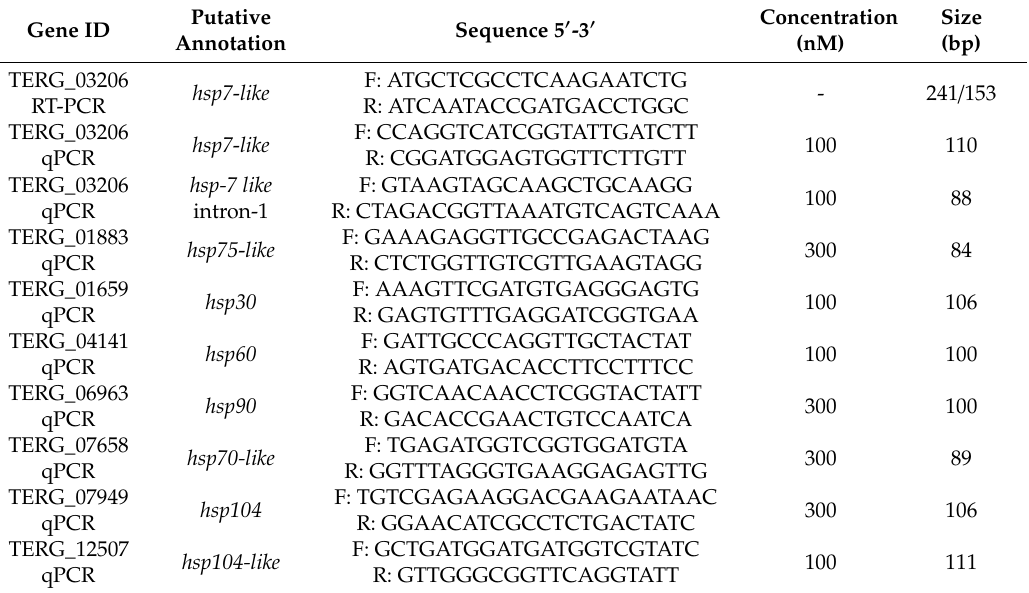
Table 1. Set of primers used in RT and qPCR